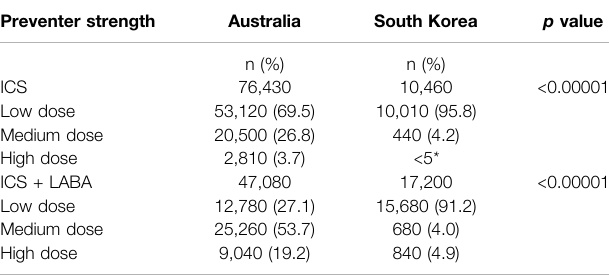
TABLE 3 | Proportion of children dispensed an ICS arranged by strength. Preventer